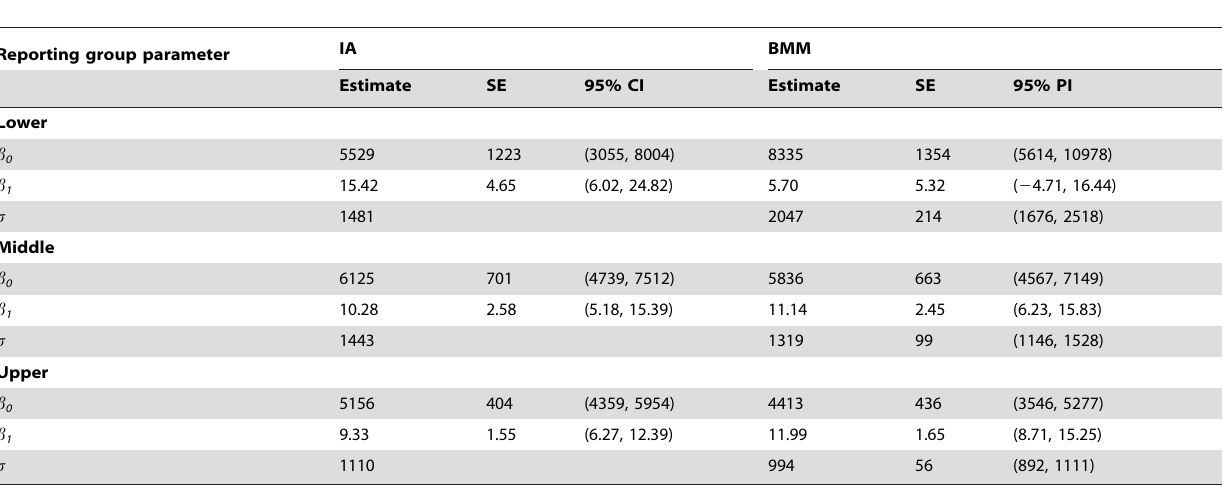
Table 4. Estimated fecundity parameters of intercept ( b 0 ), slope ( b 1 ), and standard deviation ( s ) for three reporting groups of Yukon River Chinook salmon obtained using individual assignment (IA) and Bayesian mixture modeling (BMM), with standard errors (SE) and either 95% confidence or probability intervals (CI or PI).